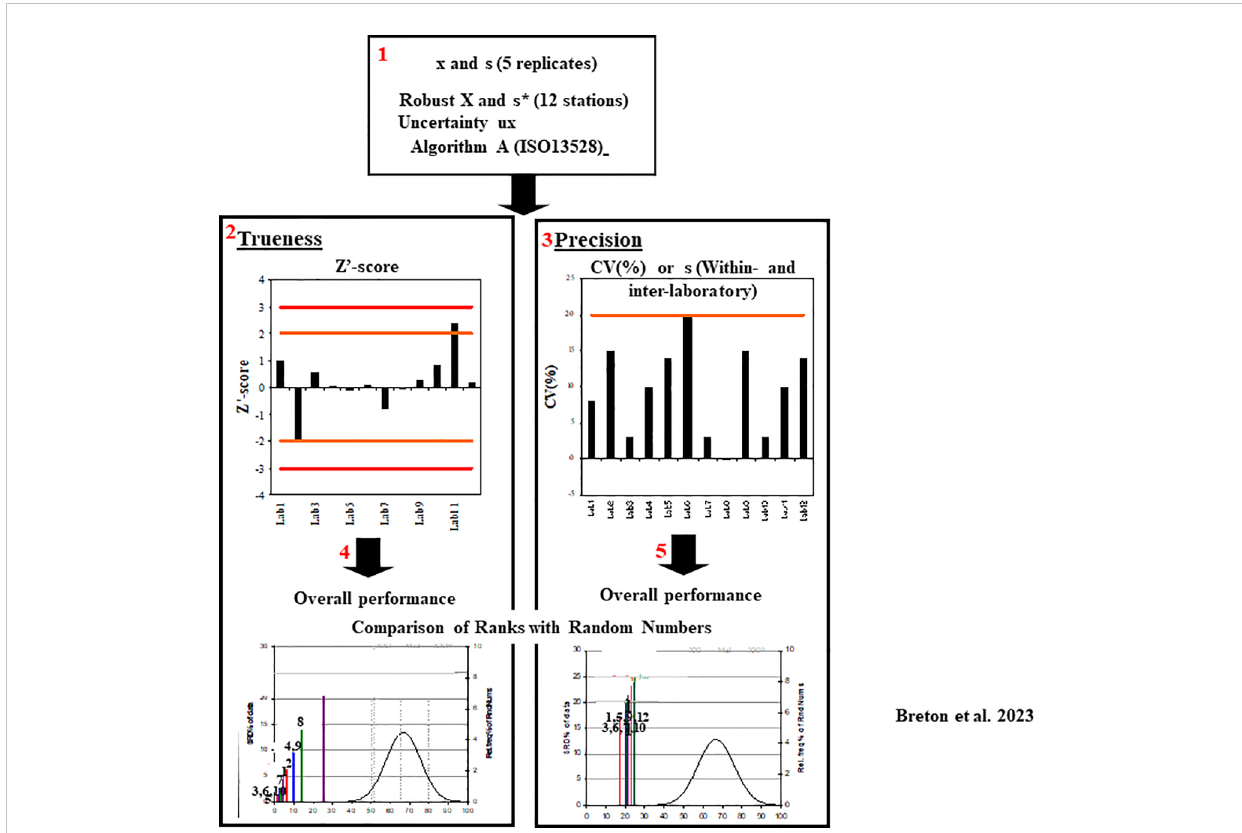
FIGURE 6 Annual ILC exercises implemented by the SOMLIT network: the different steps in the statistical methodology used to assess the total measurement accuracy of the 22 environmental variables and the participating laboratory performance. Step 1: Calculation of the mean (x) and the standard deviation (s) of replicates as well as that of the robust mean (X), standard deviation (s*), and uncertainty ( u x ) of total measurement of the measurand, by applying the algorithm A. Steps 2 and 3: Calculation of the individual deviations ( z ′ -score) to the SOMLIT robust for assessing the trueness (systematic bias) and precision (random variations). Steps 4 and 5: Calculation of the fi nal rank of each participating laboratory for the overall performance for trueness and precision (He ́ berger and Kolla ́ r-Hunek,